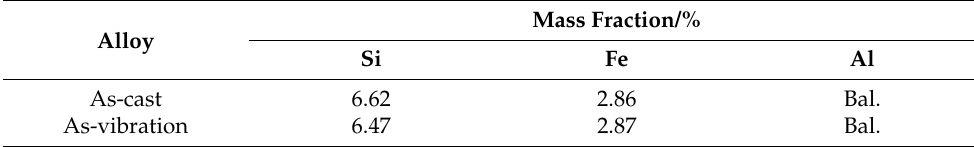
Table 1. Chemical compositions of Al-Si-Fe alloys.